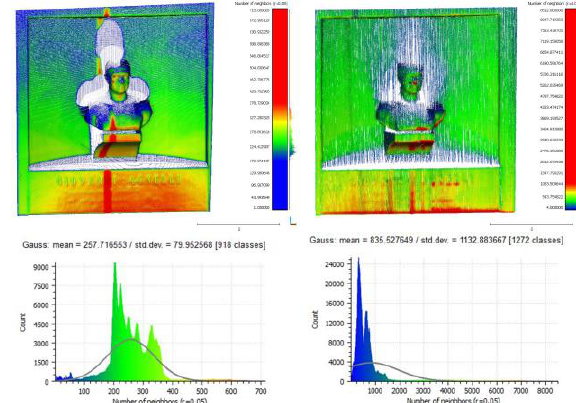
Figure 12. Giovanni Agnelli statue: density comparison between TLS (left) and MMS (right). The analysis has been performed using CC (number of neighbour analysis, pts/V sphere r = 0.05 m).